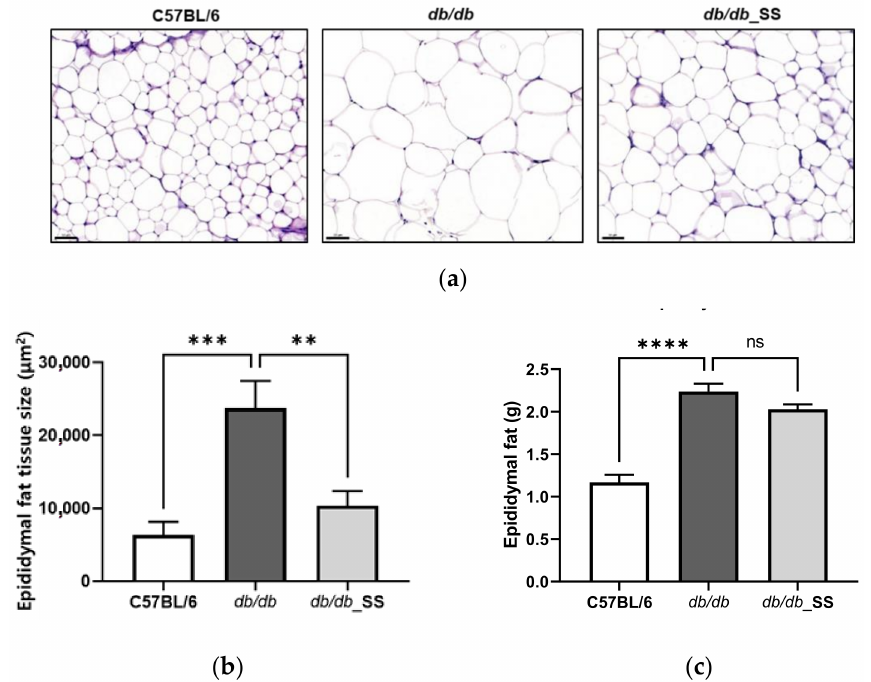
Figure 6. The effect of stevioside on the histological examination of the epididymal adipose tissue of C57BL/6 mice and db/db mice. ( a ) Paraffin sections of epididymal adipose tissue of mice treated with stevioside or vehicle were stained with H&E. Scale bar indicates 100 µ m. ( b ) The average adipocyte size of epididymal adipose tissue in mice. ( c ) The weight of epididymal fat in mice. C57BL/6; negative control group that received saline, db/db ; control group that received saline, db/db _SS; control group that received 40 mg/kg of stevioside. All data are presented as mean ± SD, and tests were performed in three independent experiments. ** p < 0.01, *** p < 0.001 and **** p <